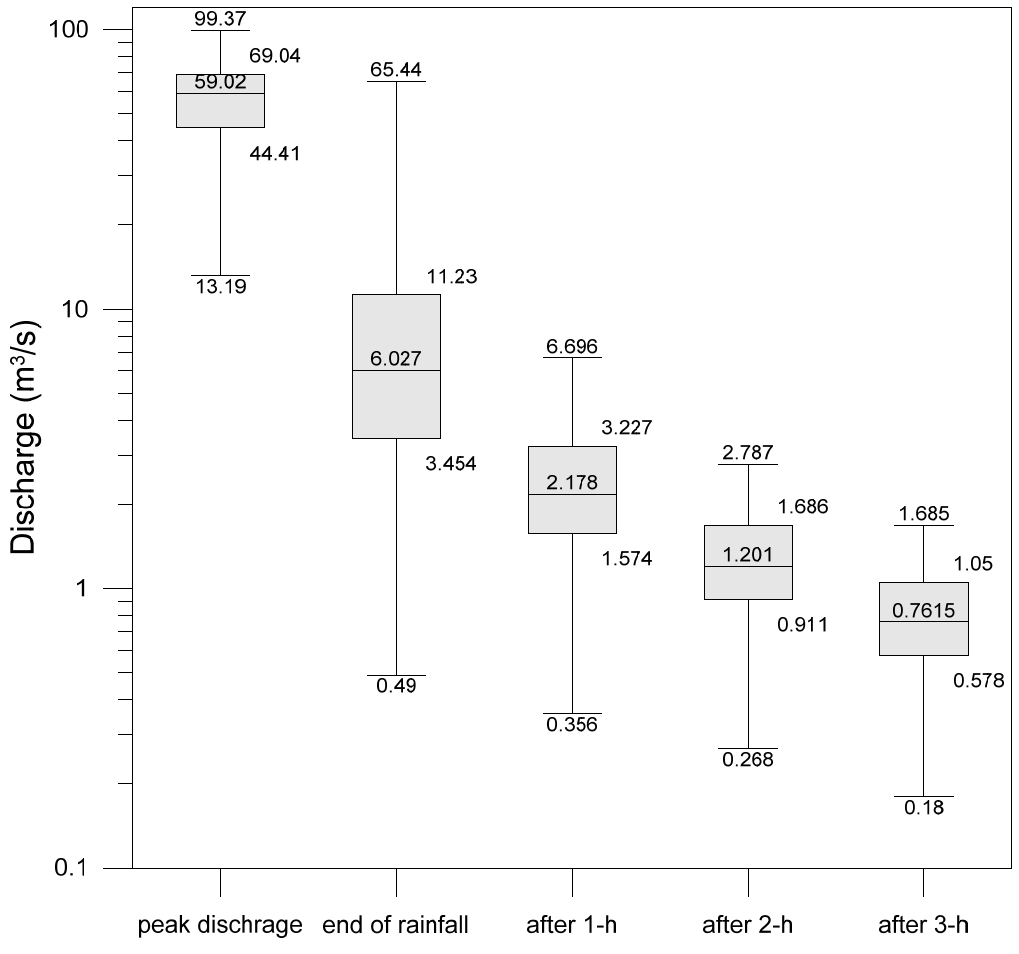
Figure 8. Box plot of the peak for the selected rainfall events.